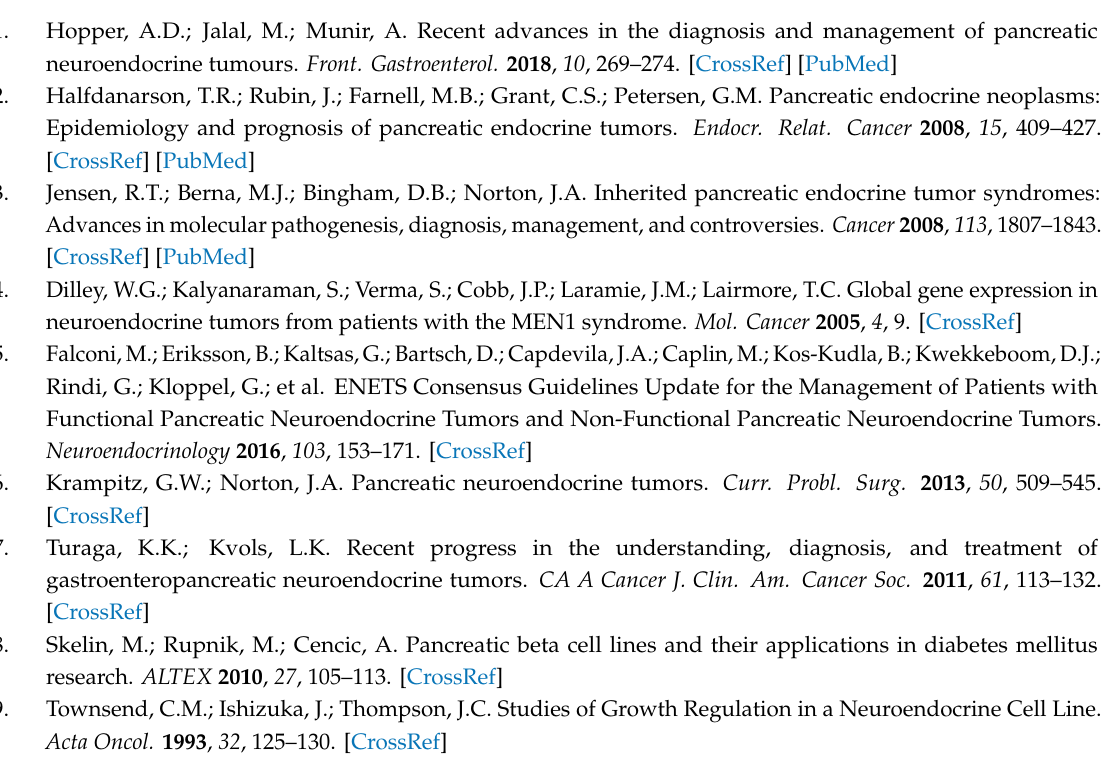
Figure S1: Currently available disease models of pNETs: cell lines, patient-derived xenograft (PDX), animal models (GEMMs), spheroids and